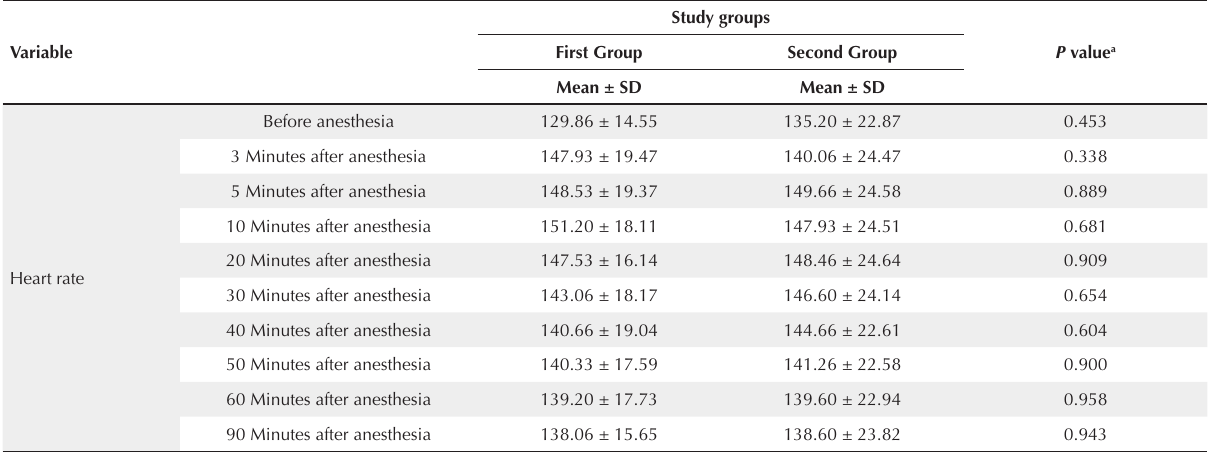
Table 3. The mean and sd of the heart rate of patients in groups 1 (ropivacaine) and 2 (lidocaine with epinephrine)